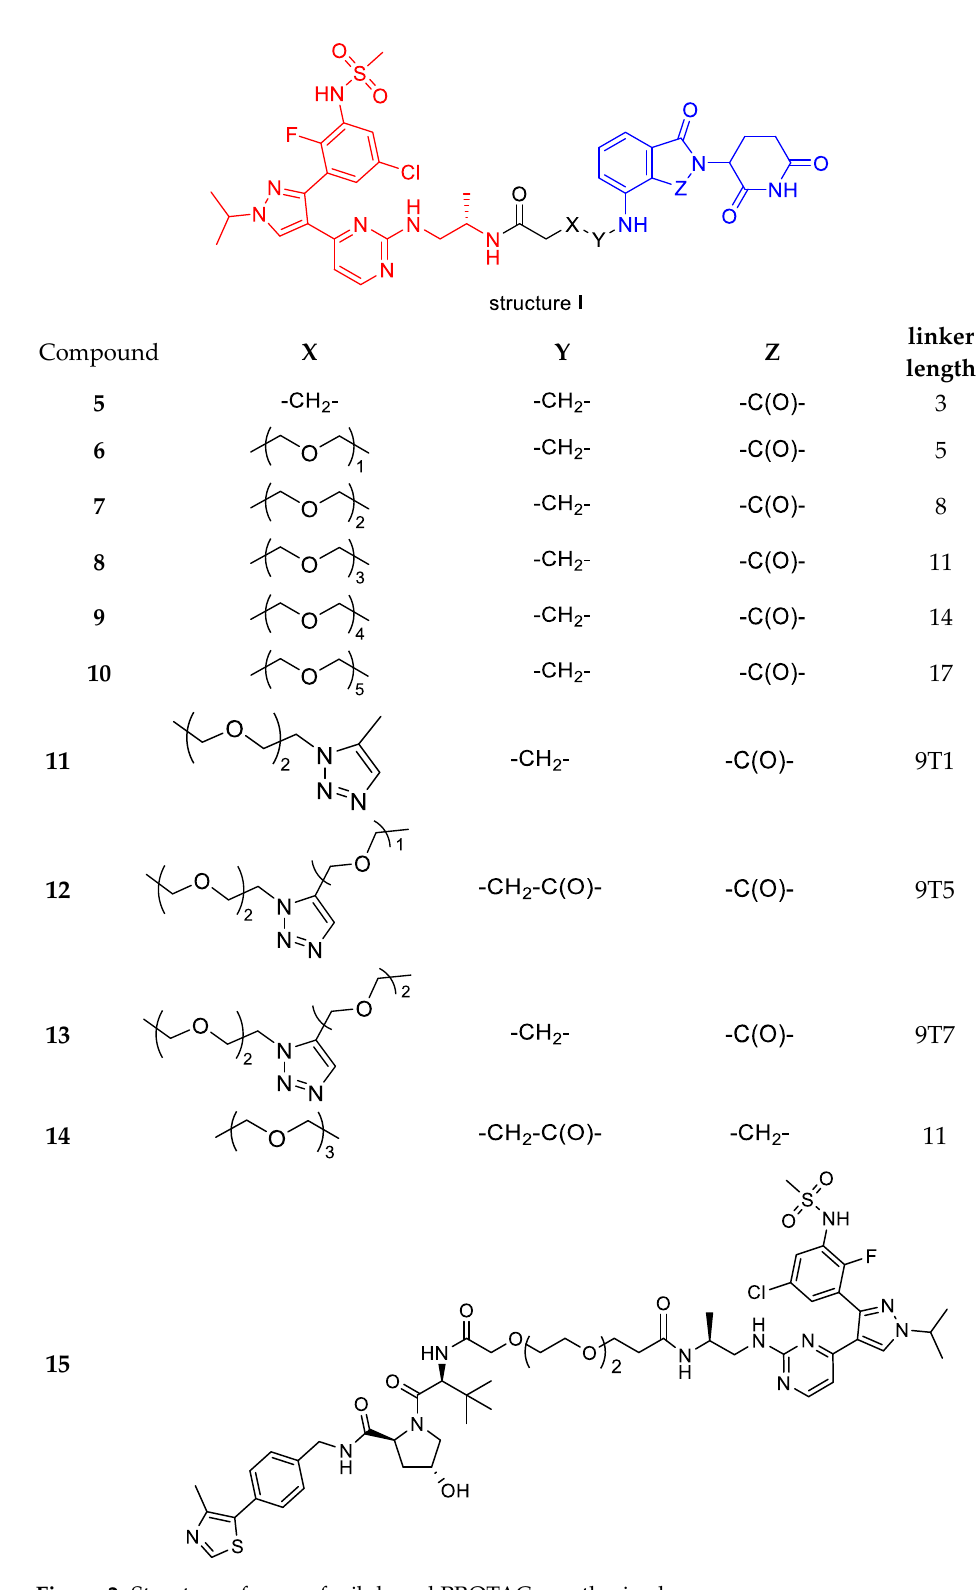
3 of 36 Figure 1. Chemical structures of encorafenib, pomalidomide, lenalidomide and VHL ligand-1. In this study, we report the synthesis and in vitro evaluation of BRAF V600E inhibition together with the antiproliferative activity in melanoma and colon cancer cell lines A375 and Colo205 of the synthesized compounds. The ability of selected compounds to induce degradation of the target protein is also discussed. Finally, we illustrate the computational studies performed to explain the lack of target degradation in comparison with compound P5B [24], a recently disclosed BRAF V600E degrader. 2. Results and Discussion 2.1. Chemistry In order to obtain compounds bearing the BRAF V600E ligand and the CRBN ligand at different spatial positions, the PEG-derived linkers were selected to cover a wide range,